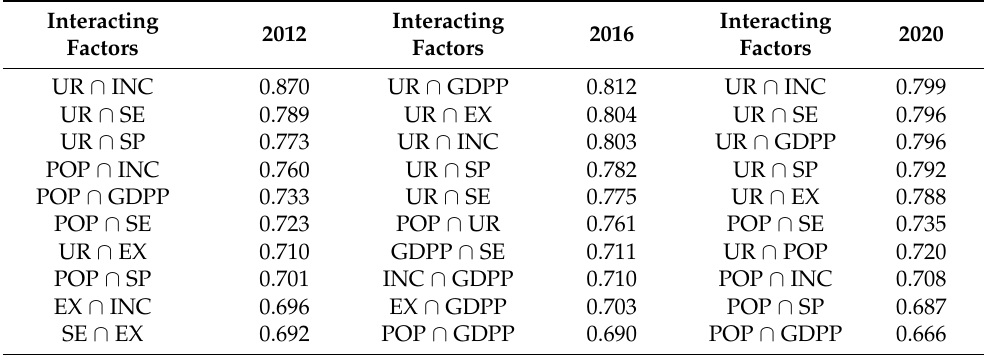
Table 6. Detection results of interaction for influencing